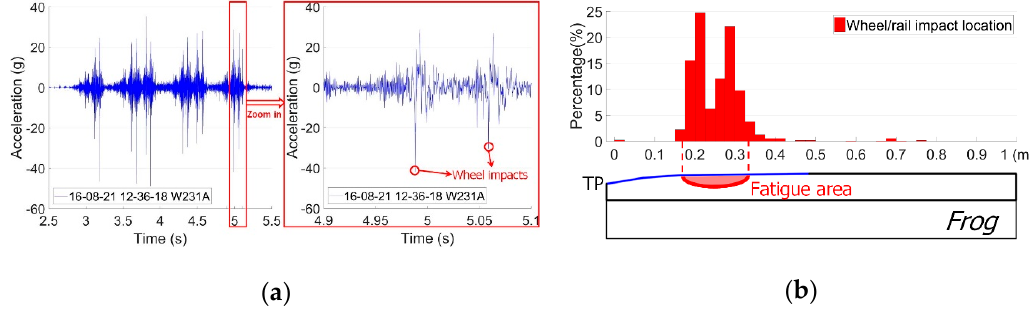
Figure 3. Examples of the output of crossing instrumentation. ( a ) Vertical acceleration response due to one train’s passage; ( b ) wheel impact location distribution.